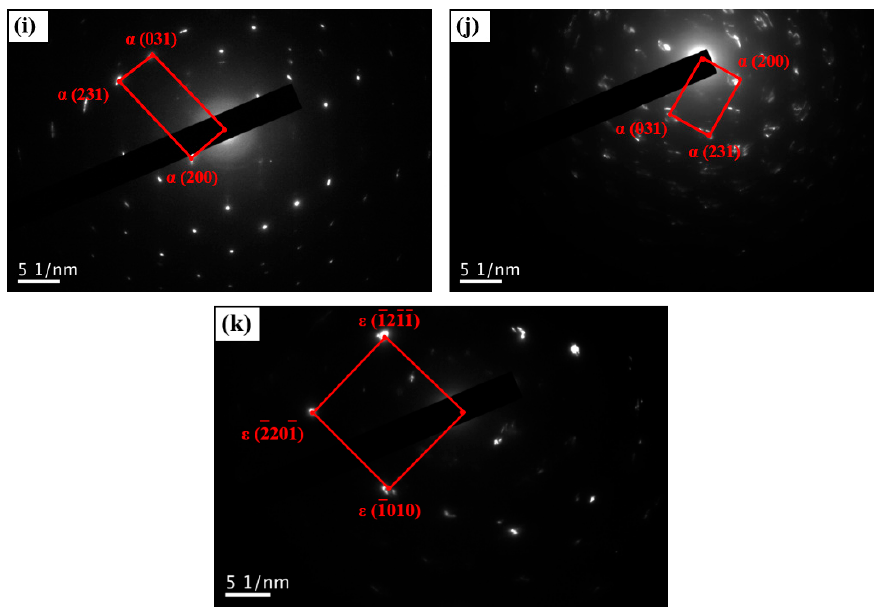
Figure 9. TEM images on different location of the worn specimens at 8000 magnification. ( a , b ) Nonworn surface ( c , d ) worn surface I, ( e – h ) worn surface II, SAED patterns of ( d , f , h ) are given in ( i , j , k ), respectively.